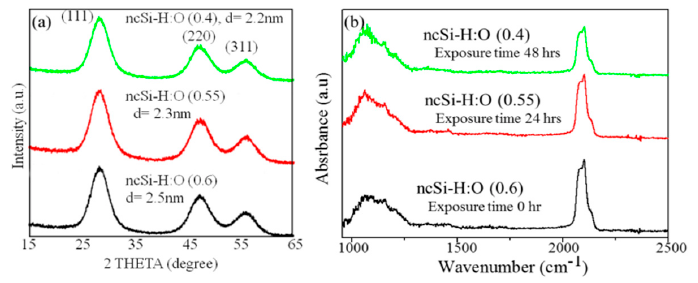
Figure 1. ( a ) XRD patterns and ( b ) attenuated total reflectance Fourier transform infrared spectroscopy Figure 1. (a) XRD patterns and (b) attenuated total reflectance Fourier transform infrared spectroscopy (ATR-FTIR) (ATR-FTIR) spectra of the ncSi-H:O spectra of the ncSi-H:O samples.